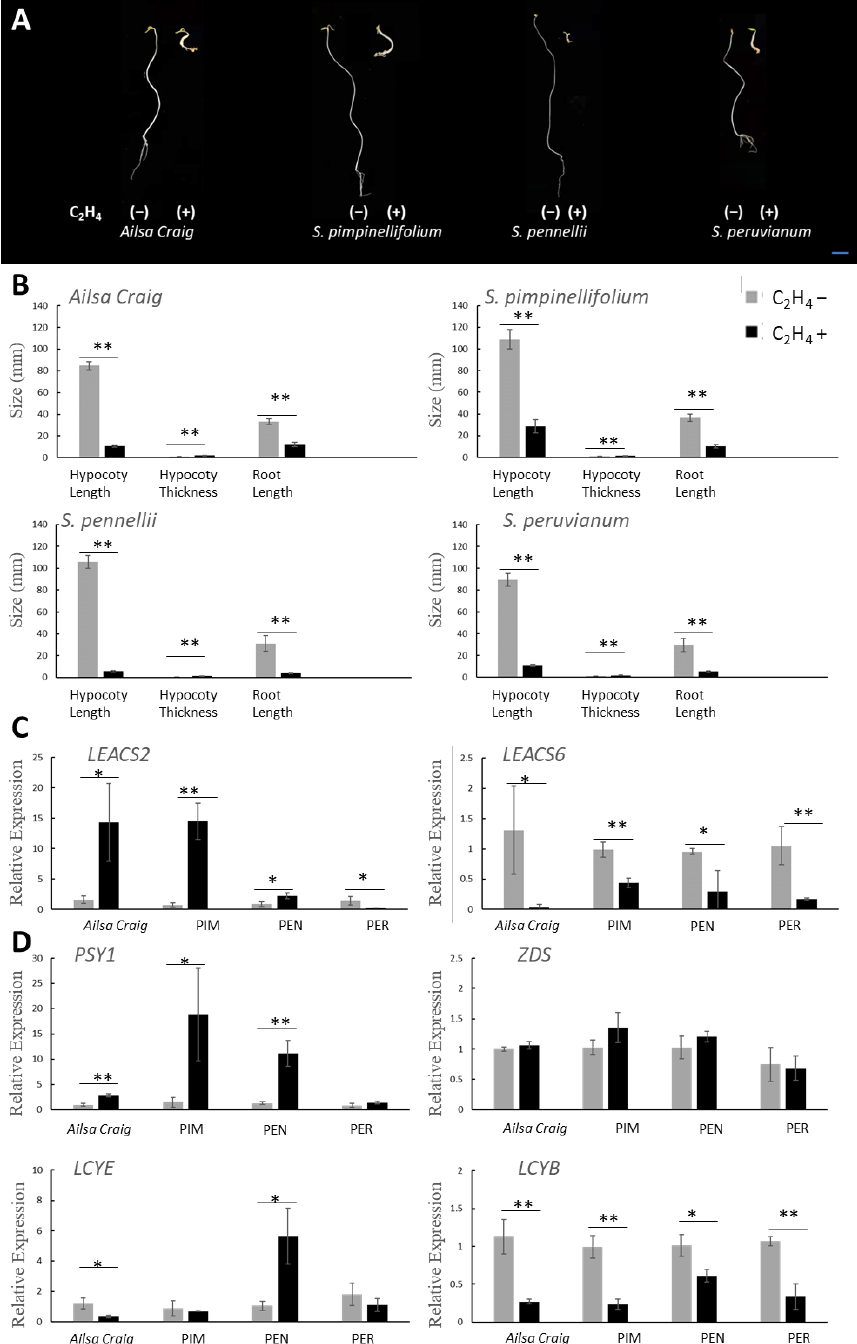
Figure 4. Responsiveness of tomato species to exogenous ethylene. Triple response assay of seedlings ( A , B ) and gene expression in fruits exposed to exogenous ethylene ( C , D ). Gray bars represent controls, while black bars indicate ethylene-treated samples. Ailsa Craig , S. lycopersicum cv. Ailsa Craig; PIM, S. pimpinellifolium ; PEN, S. pennellii ; PER, S . peruvianum. Asterisks indicate significant differences as determined by the t -test (* p < 0.05, ** p < 0.01). Expression of LEACS2 was positively induced by exogenous ethylene treatment in tomato fruits, except in S. peruvianum . LEACS2 expression increased eight-, 20-, and two- fold in Ailsa Craig, S. pimpinellifolium , and S. pennellii , respectively, when treated with